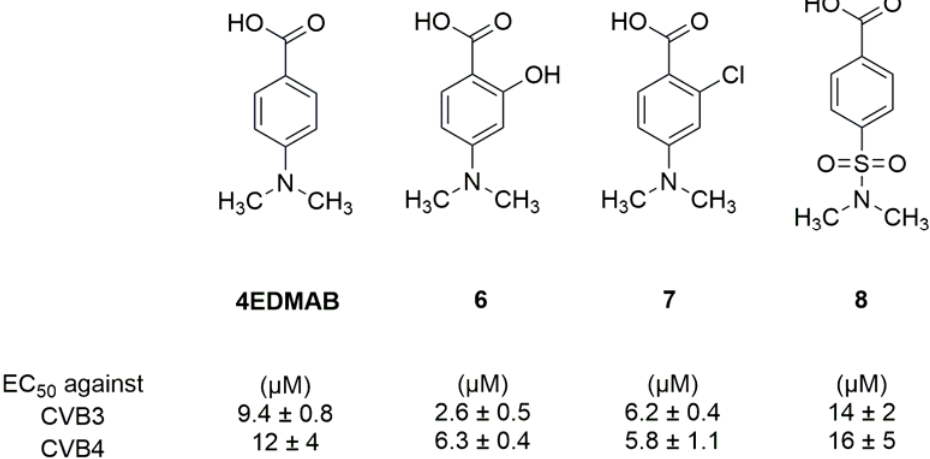
Figure 7. Chemical structures and activities against CVB3 and CVB4 of 4EDMAB and compounds 6 – 8